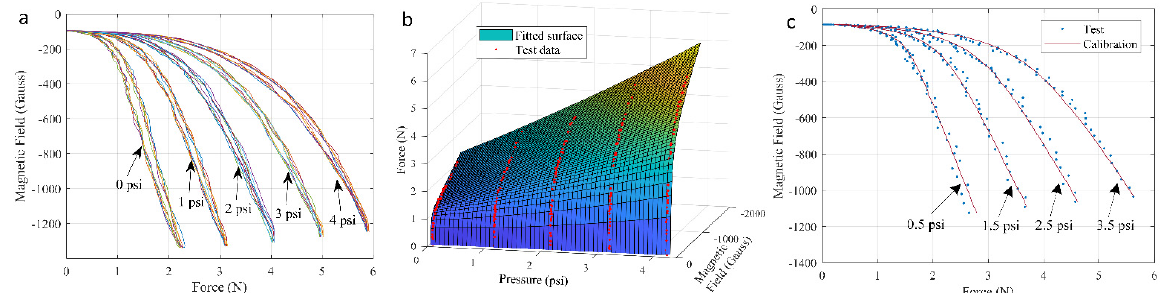
Figure 8. ( a ) Magnetic field ( Z -axis, averaged) response to the indentation force for the Ecoflex 0050 sample which is pressurized at different fluidic pressure. ( b ) Fitted surface stands for the relation between force vs. magnetic field ( Z -axis) and pressure. ( c ) Calibration by fitted surface using 1 to 4 psi (1 psi increment) on 0.5 to 3.5 psi (1 psi increment) test conditions.